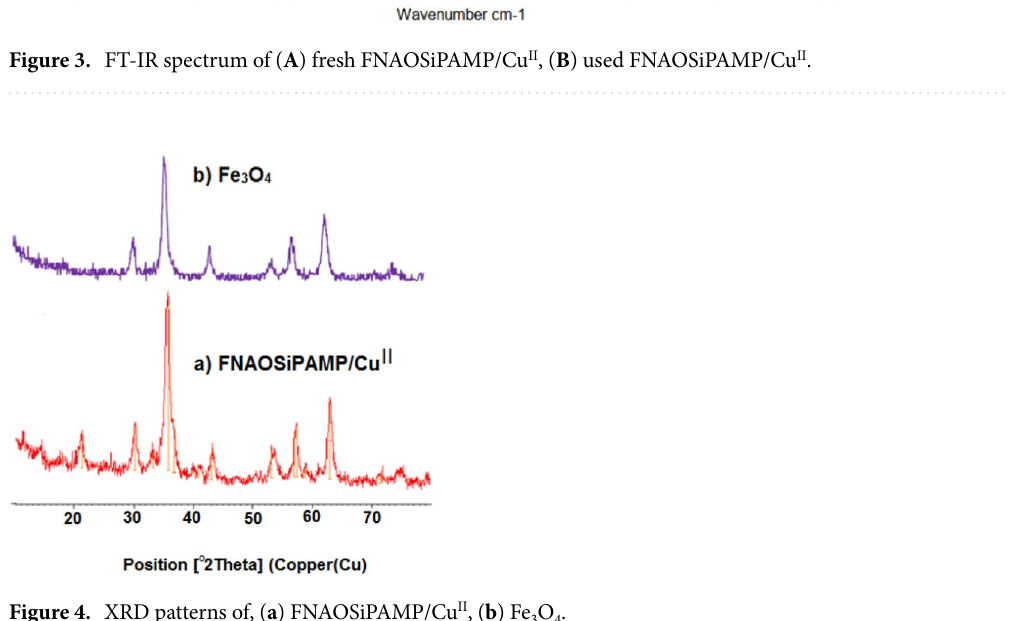
Figure 4. XRD patterns of, ( a ) FNAOSiPAMP/Cu II , ( b ) Fe 3 O 4